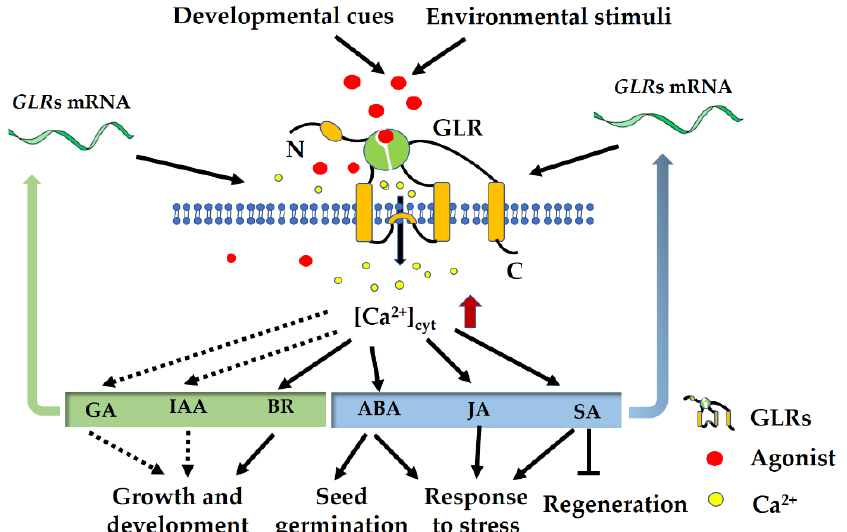
Figure 3. Glutamate receptor-like channel (GLR)-mediated Ca 2+ signaling regulates hormone signal- ing to regulate plant growth and stress response. GA, gibberellic acid. IAA, indole-3-acetic acid. BR, brassinosteroid. ABA, abscisic acid. JA, jasmonic acid. SA, salicylic